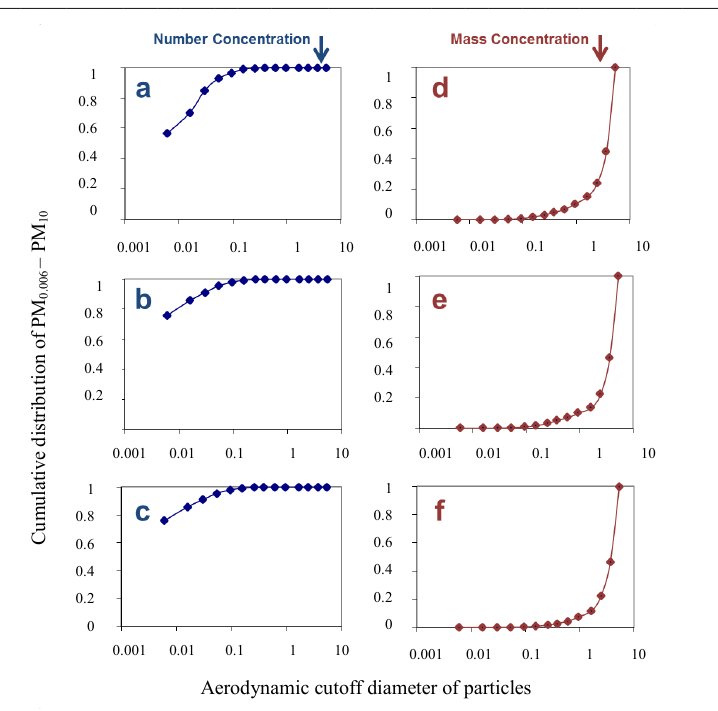
Fig. 3. Cumulative distribution of PM 0.006 – PM 10 by number: a) in the 3D printing premise ( with opened doors to the large room); b) in the 3D printing premise ( with closed doors to the large room); c) in the large 3D printing office’s premise. Cumulative distribution of PM 0.006 – PM 10 by mass: d) in the 3D printing premise ( with opened doors to the large room); e ) in the 3D printing premise ( with closed doors to the large room); f) in the large 3D printing office’s